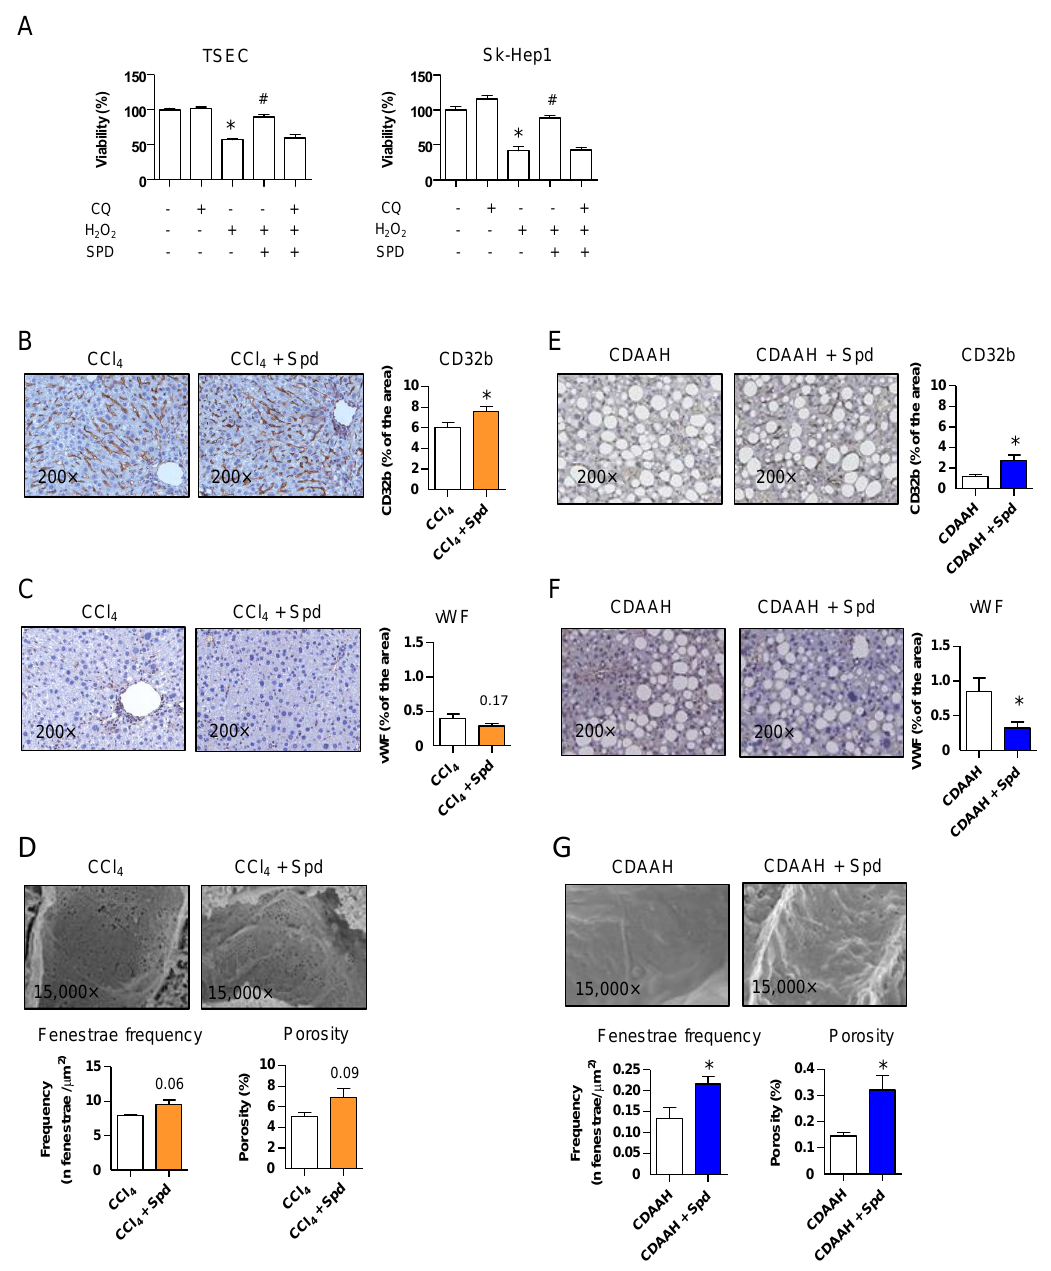
Figure 1. SPD improves the LSEC viability in vitro and the endothelial phenotype in vivo. ( A ) TSEC and SK-Hep1 viability studies upon H 2 O 2 damage measured by MTS assay. The cells were seeded in 96-well plates in triplicates. The next day, the cells were pretreated with SPD or SPD + CQ for 24 h. The medium was then changed, and H 2 O 2 was added for another 24 h before adding the MTS solution. One representative of the three independent experiments is shown. ( B , E ) CD32b immunohistochemistry and quantification in whole liver tissue sections from the CCl 4 and CDAAH mice, respectively. ( C , F ) Immunohistochemistry and quantification of vWF in whole liver tissue sections from the CCl 4 and CDAAH mice, respectively. ( D , G ) Fenestrae frequency and porosity were measured by SEM in livers from the CCl 4 and CDAAH mice, respectively. For the IHC studies, n = 7–10 mice per group. For the SEM studies, n = 5–6 mice per group. The results are the means ± SEM; * p < 0.05 compared to the correspondent control; # p < 0.05 compared to the H 2 O 2 treatment (Student’s t